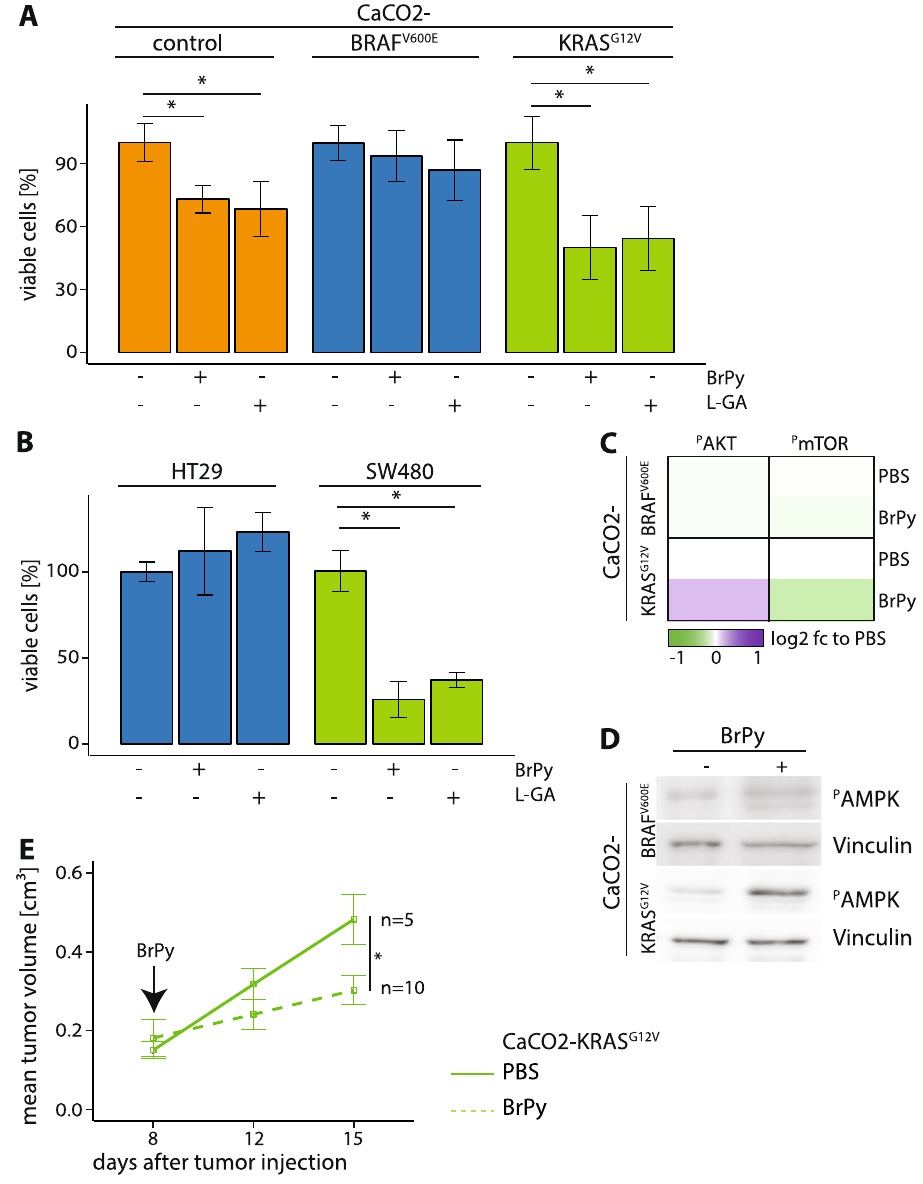
Figure 6. Cells expressing KRAS G12V were sensitive for glycolytic inhibition in vitro and in vivo . ( A , B ) CaCO2- control, CaCO2-BRAF V600E , CaCO2-KRAS G12V , HT29 and SW480 cells were grown in physiological (1.0 g/L) glucose concentrations and treated with 0.25 mM 3-Bromopyruvate (BrPy), 1 mM L-glyceraldehyde (L-GA) or PBS ( − ) for 24 h. Viable cells compared to PBS are depicted. Shown are standard deviation of (in minimum) n = 3 replicates. p < 0.05 was indicated with asterisk (unpaired two-tailed t Test). ( C ) Phosphorylation of signaling molecules were analyzed with ELISA bead-based phosphoproteomics technology (Luminex). Shown are log2 fold changes (fc) to PBS. ( D ) CaCO2-BRAF V600E and CaCO2-KRAS G12V treated with 0.25 mM BrPy ( + ) or PBS ( − ) for 24 h were analyzed with antibodies against phospho-AMPK (Thr172). Vinculin served as loading control. Representative images are shown. Full-length blots are shown in the Supplementary Information. ( E ) CaCO2-KRAS G12V cells were subcutaneously injected into the right flank of mice receiving 200 µ L PBS or BrPy (8 mg/kg) in the presence of Doxycycline treatment every 2 days (starting from day 8) by intraperitoneal injection. Mean of tumor volume is shown for indicated mice per group up to 15 d. Shown are standard deviation of n = 5 (control group) and n = 10 (BrPy group) replicates. p < 0.05 was indicated with asterisk (unpaired two-tailed t